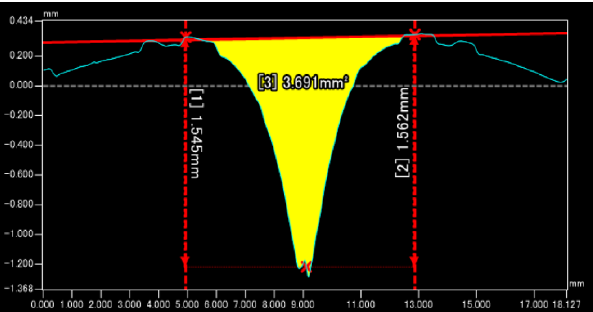
Figure 2. An example of groove shape measurement. The green line shows the shape of the ball surface, the red line indicates the depth of the groove, and the yellow area denotes the cross section of the groove.